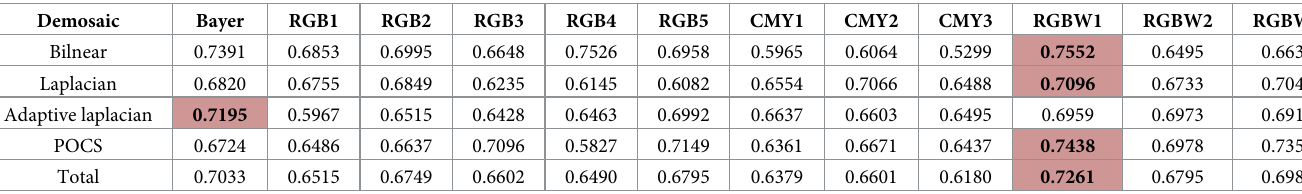
Table 3. Performance comparison of test CFAs by normalized